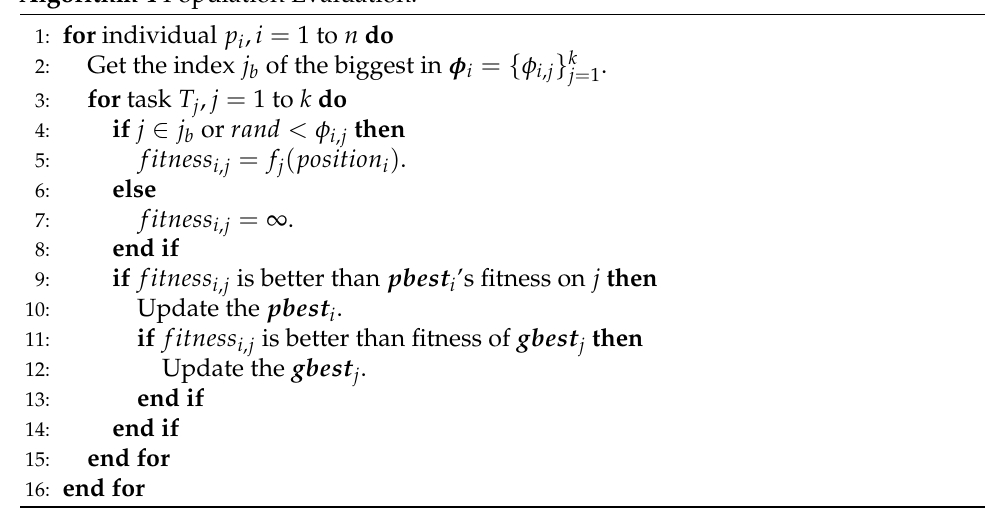
Algorithm 4 Population